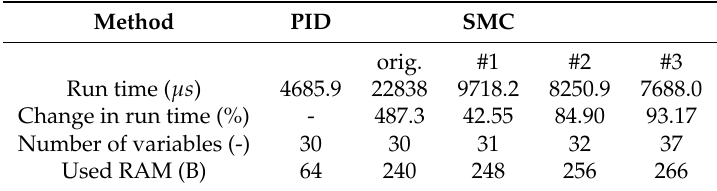
Table 7. Comparison of different controller